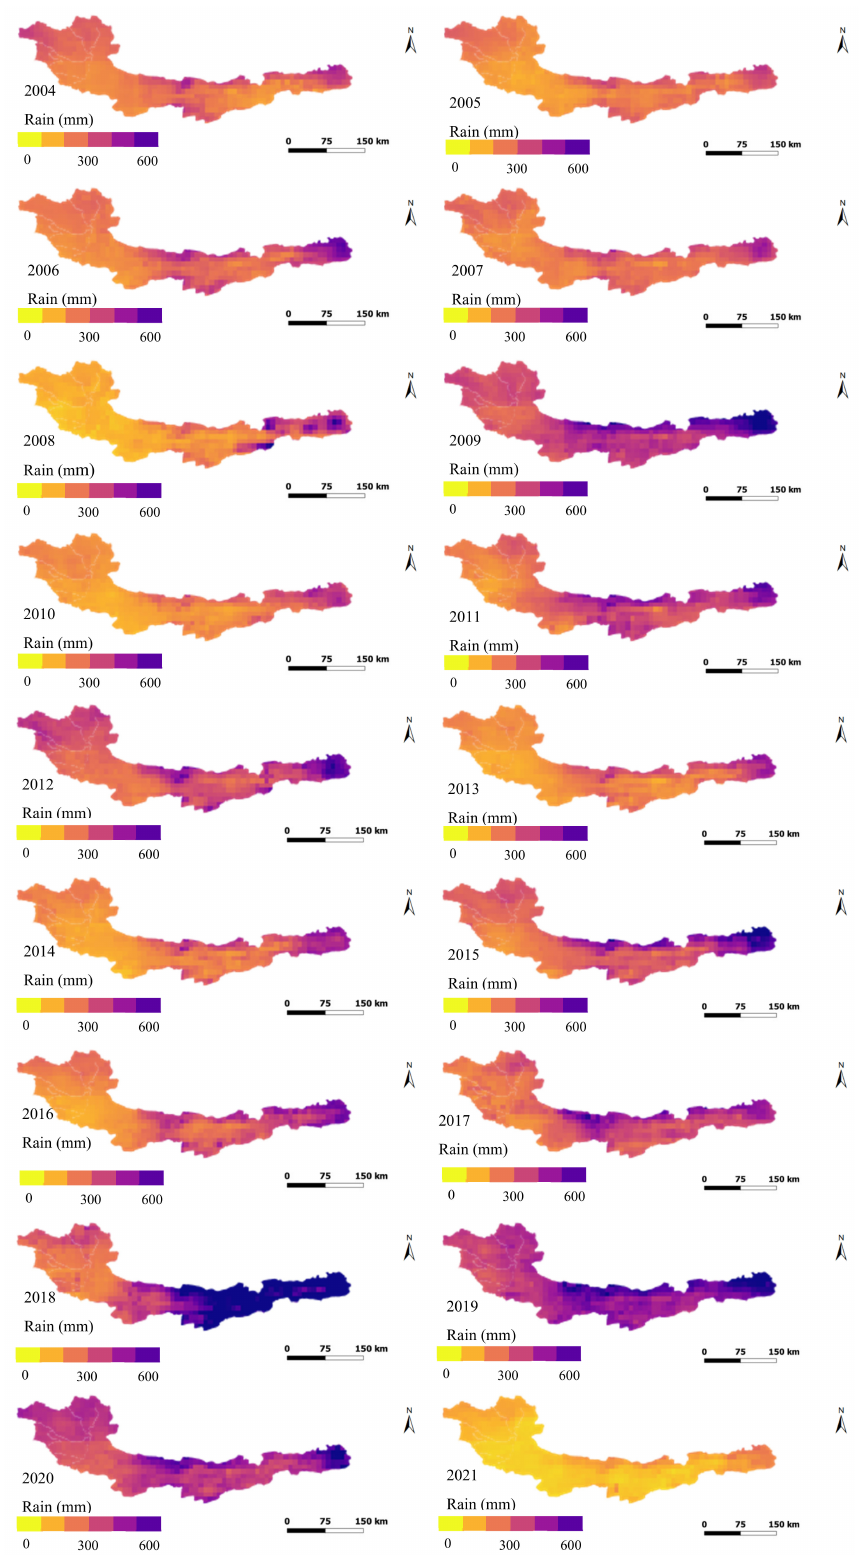
Figure 5. The spatial–temporal distribution of annual rainfall (mm) from the CHIRPS product derived from GEE in the period of